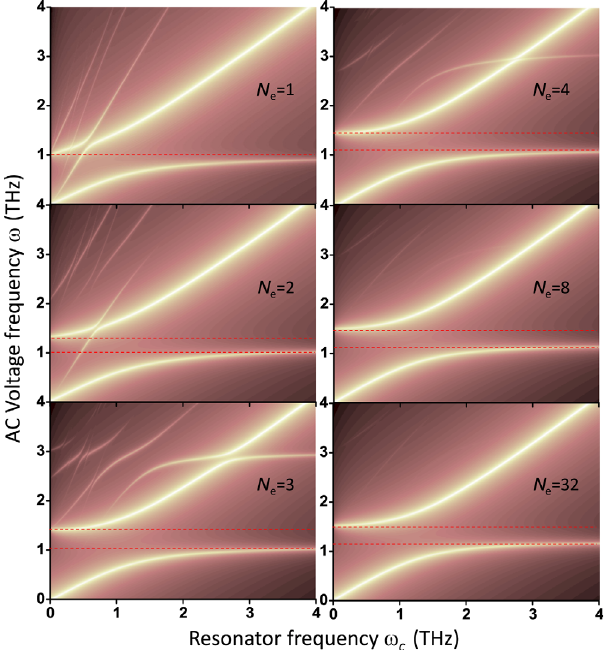
FIG. 6. Absorption spectra of the coupled circuit-matter system with a variable number of electrons N e . The parameters for these plots are identical to those in Fig.